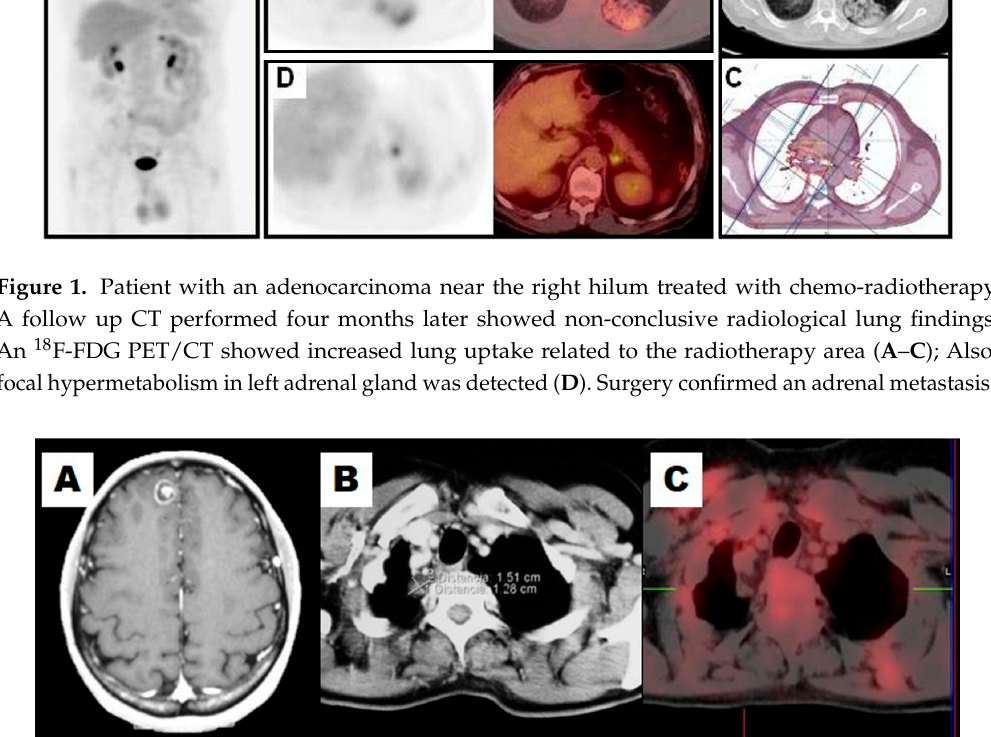
Figure 2. This example illustrates how 18 F-FDG PET/CT would rule out the suspicion of recurrence. A resectable isolated cerebral lesion was diagnosed in a 48-year-old female after treatment of NSCLC ( A ). She had a previous lobectomy and a left adrenalectomy. Taking into account the resectability of the cerebral lesion, a CT for restaging showed a solitary nodule in the right upper lung ( B ); An 18 F-FDG PET/CT showed no pathological uptake in the lung nodule ( C ); The patient was treated with stereotaxic surgery over the cerebral lesion. Three years later, she remained asymptomatic.